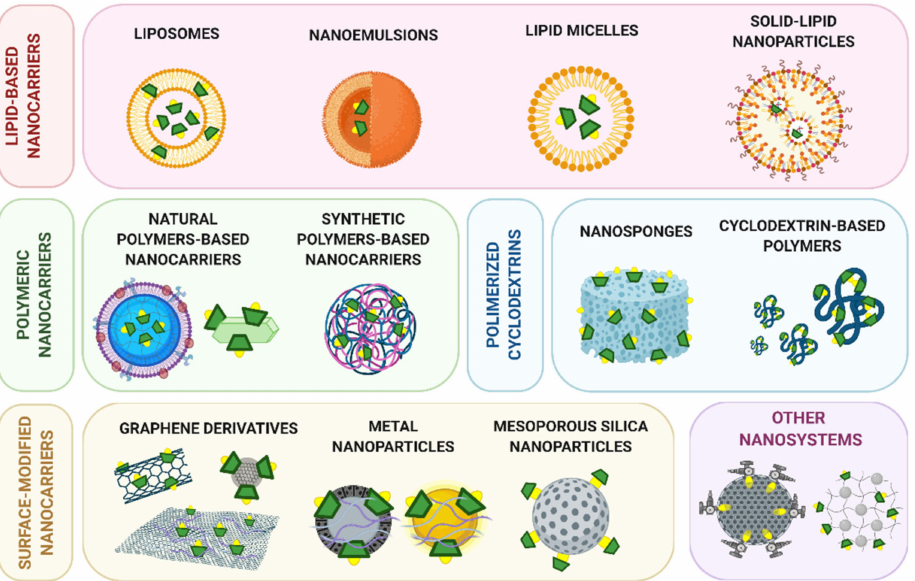
Figure 2. General classification of CD-modified nanomaterials applied to drug delivery composed of CDs and their deriva- tives, drugs, polymers, and nanomaterials, considering the characteristics and composition. Created with